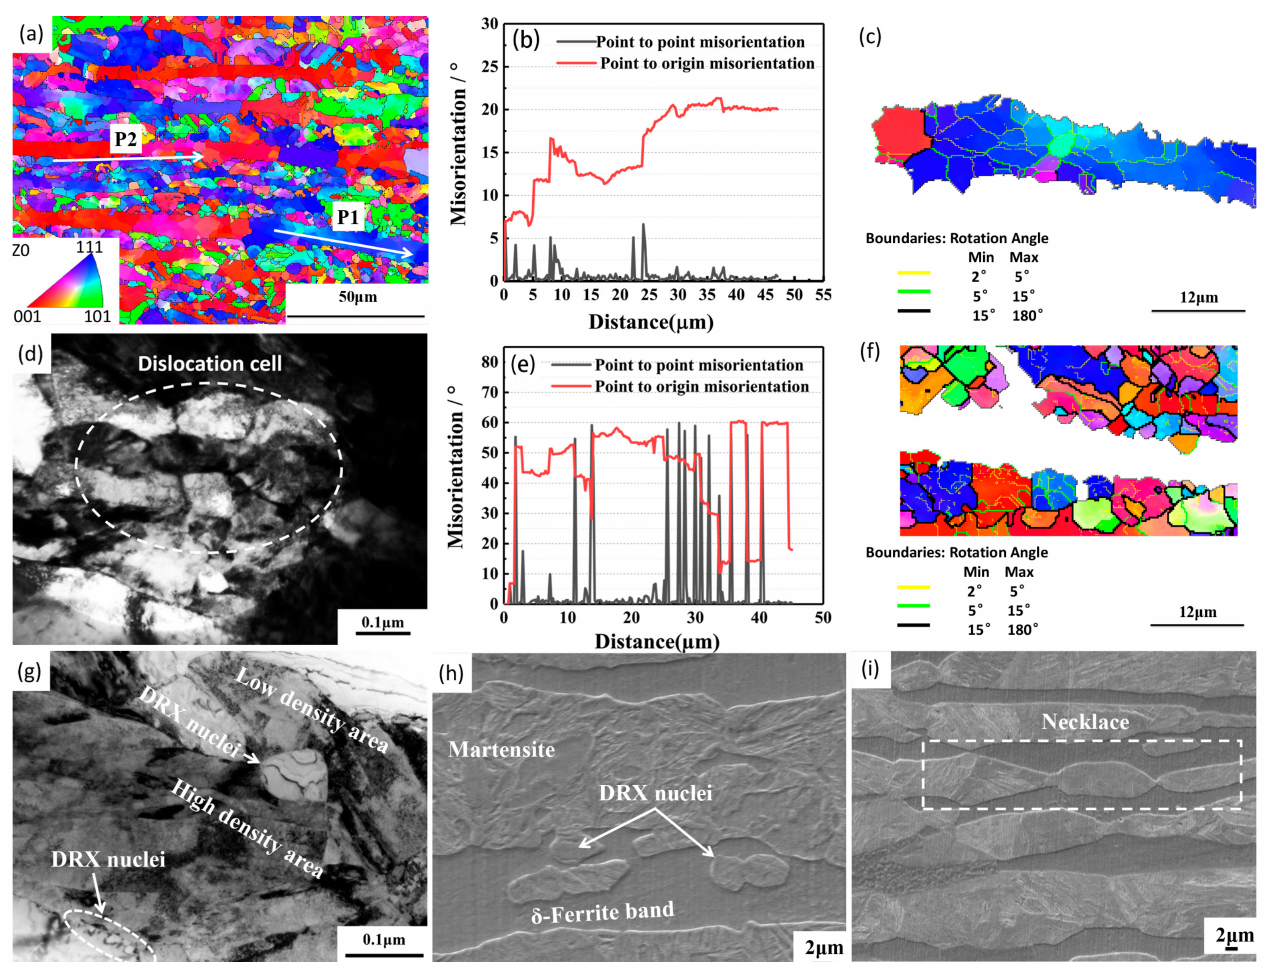
Figure 15. DRX behavior under deformation conditions of 1000 ◦ C and 20 s − 1 . ( a ) IPF map, ( b ) grain boundary misorienta- tion angle in δ -ferrite, ( c ) grain and sub grain boundary map of δ -ferrite, ( d ) formation of dislocation cell, ( e ) grain boundary misorientation angle of austenite, ( f ) grain and sub grain boundary map of austenite, ( g ) formation of DRX nuclei, ( h ) DRX grains nucleate adjacent serrated GBs, and ( i ) grain necklaces along original grain